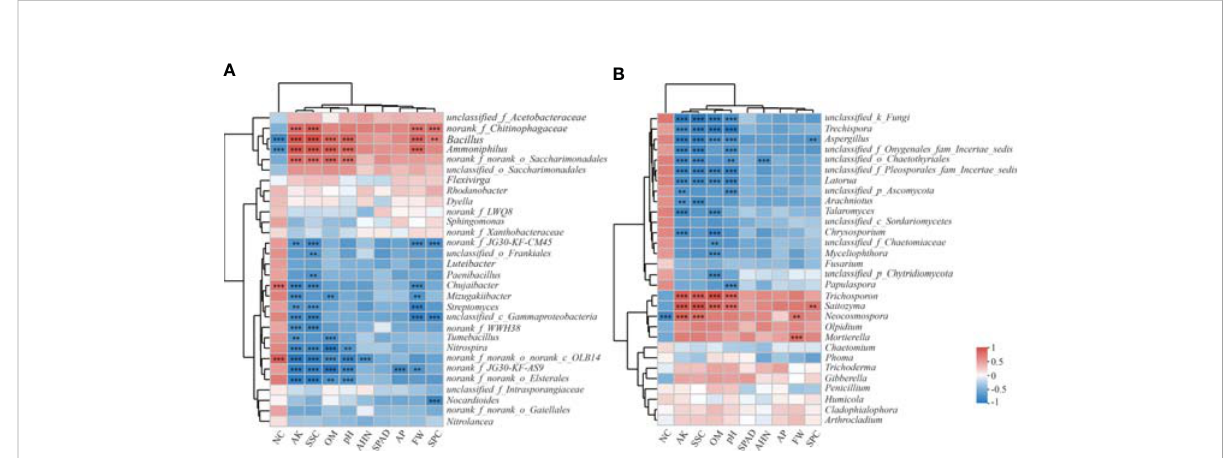
FIGURE 5 Heatmap analysis of the correlation between the species composition of soil bacteria (A) and fungi (B) at the genus level and environmental factors and agronomic traits. CK is untreated control; CF is chemical fertilizer; OF is organic fertilizer; BF is bioorganic fertilizer; FW is fresh weight; SPAD is leaf SPAD value; NC is nitrate concentration; SSC is soluble sugar concentration; SPC is soluble protein concentration; AHN is alkaline hydrolysis nitrogen; AP is available phosphorus; AK is available potassium; OM is organic matter. The Spearman method was used for correlation analysis. The legend on the right is the color interval for the different R values. The number of asterisks indicates the degree of correlation: *0.01 < P ≤ 0.05; **0.001 < P ≤ 0.01; *** P ≤